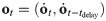
Analysis of policy parameters, with CMA-ES applied to ot=(o˙t,o˙t-tdelay).